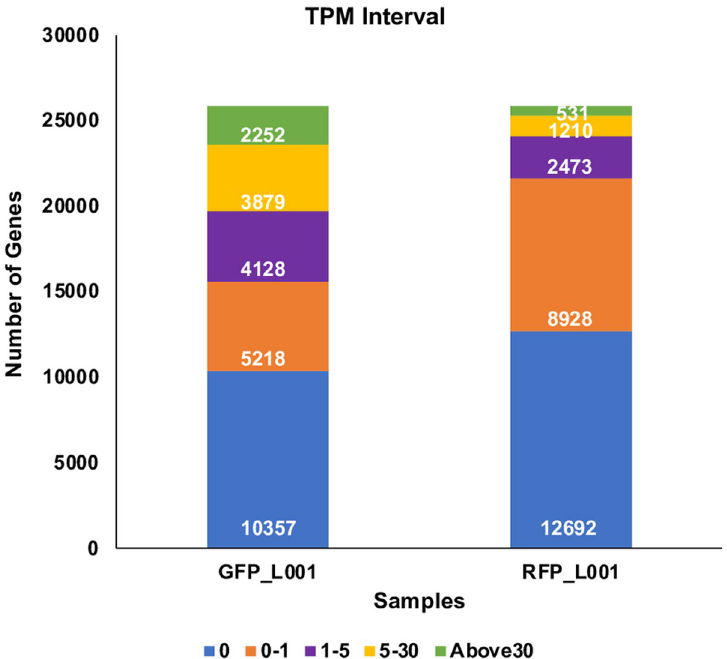
Fig 3. Transcripts per million (TPM) distribution for each of the two samples GFP_L001 and RFP_L001 representing GFP+ and RFP+ thrombocytes. Transcripts from 24 scRNASeq files, 12 for GFP+ and 12 for RFP + thrombocytes were quantified. Among these files, 4 GFP+, and 4 RFP+ files (in fastq format) that showed a mapping percentage of almost 45–46% to the zebrafish genome were chosen. The 4 GFP fastq files were merged to one fastq file, and similarly 4 RFP fastq files were also merged to one fastq file and used in TPM analysis. Bar graphs show TPM distribution obtained in this analysis and are divided into five intervals for each sample representing the number of genes with TPM values from 0 to > 30, and these TPM values are coded by different colors with a key shown